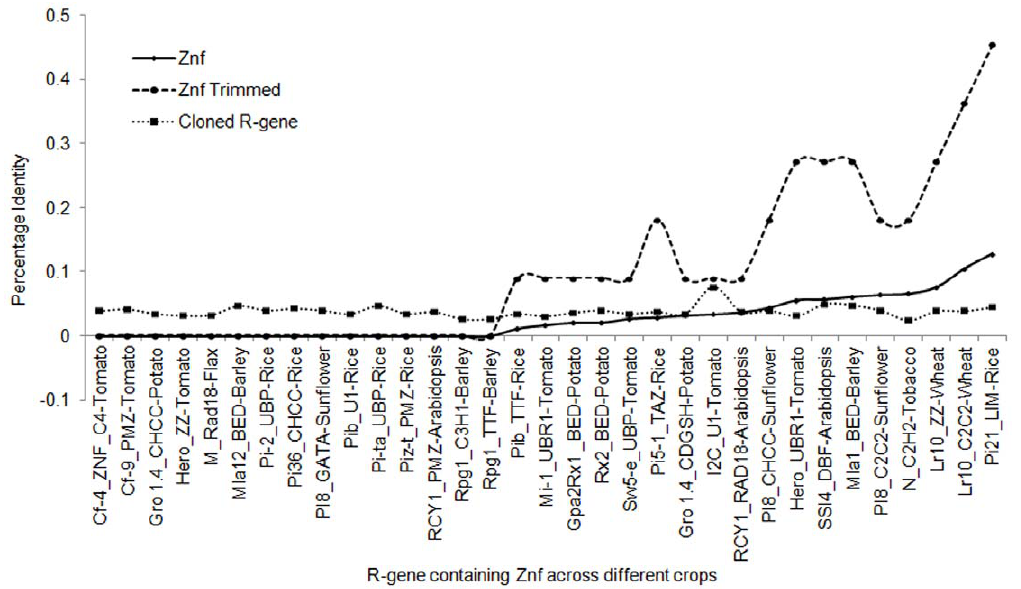
Figure 9. Pair-wise percentage identity profile. The Graphical representation showed the pair wise percentage identity profile of zinc finger domains of cloned R genes with respect to NFX domain of Pi54 gene. This analysis includes the comparison between the complete protein sequences of zinc finger containing R-proteins, Zinc finger domains of these proteins and 11 amino acid trimmed sequences showed similarity with Pi54 zinc finger domains. The X-axis of the graph represents the zinc finger containing cloned R genes across different crops whereas Y-axis represent the percentage identity profile between zinc fingers with respect to Pi54.